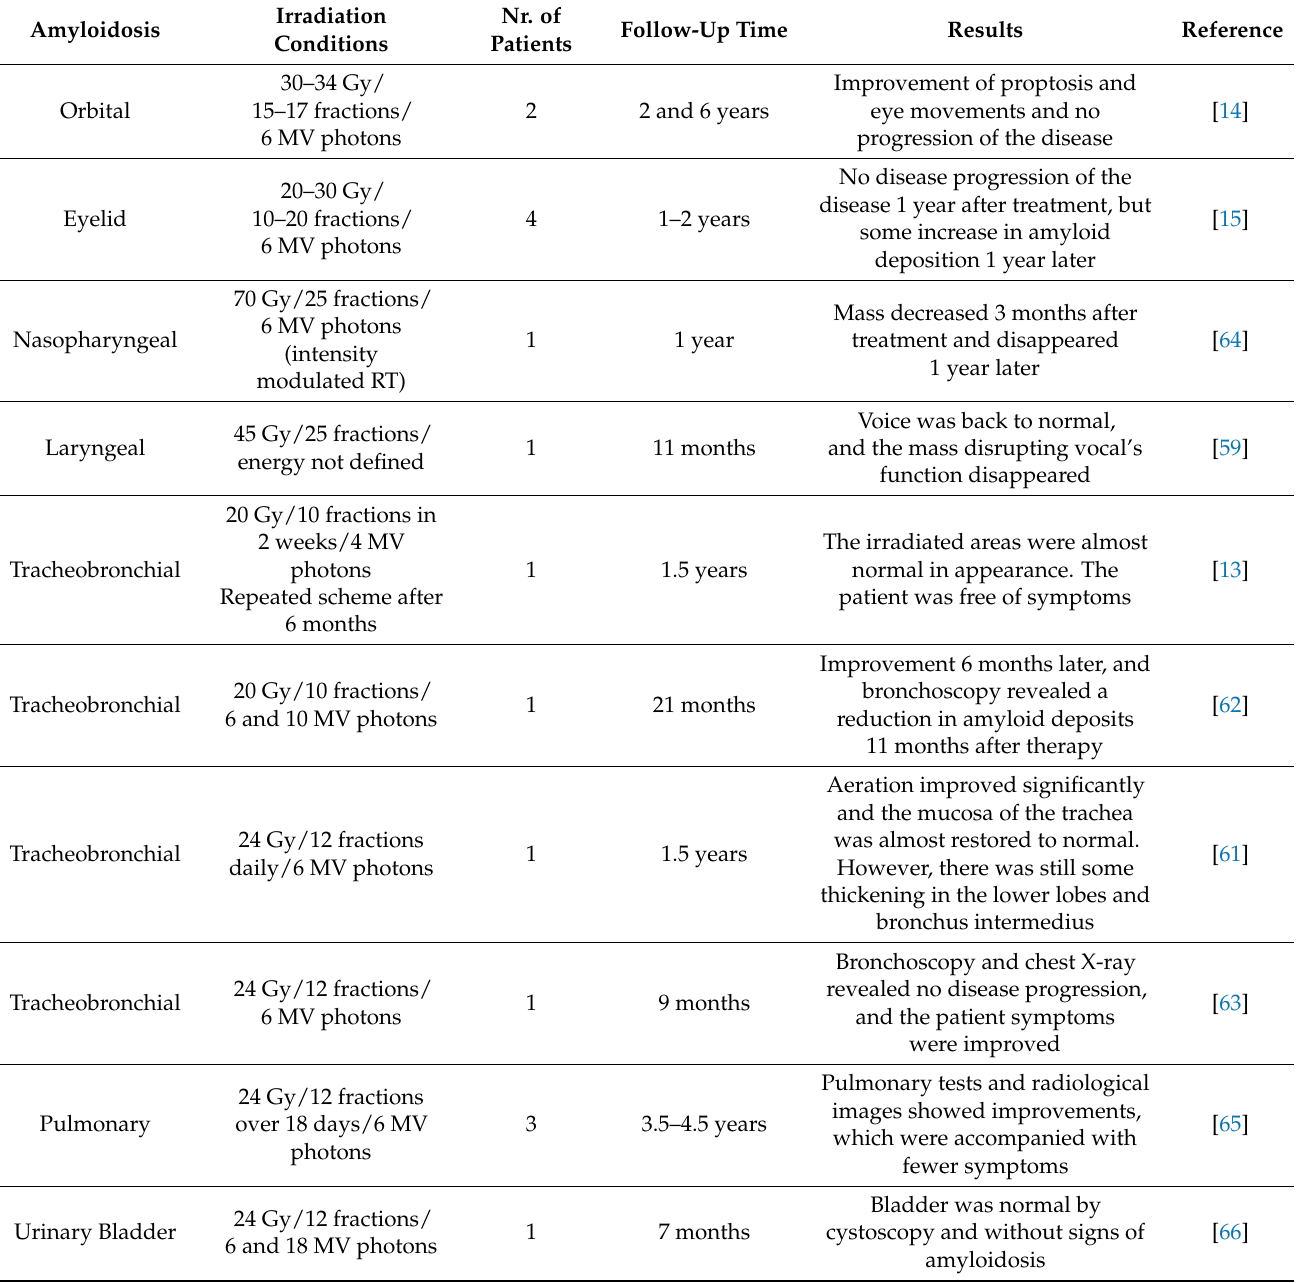
Table 1. List of reviewed studies describing the use of RT with fractionated dose schemes in amyloi- dosis